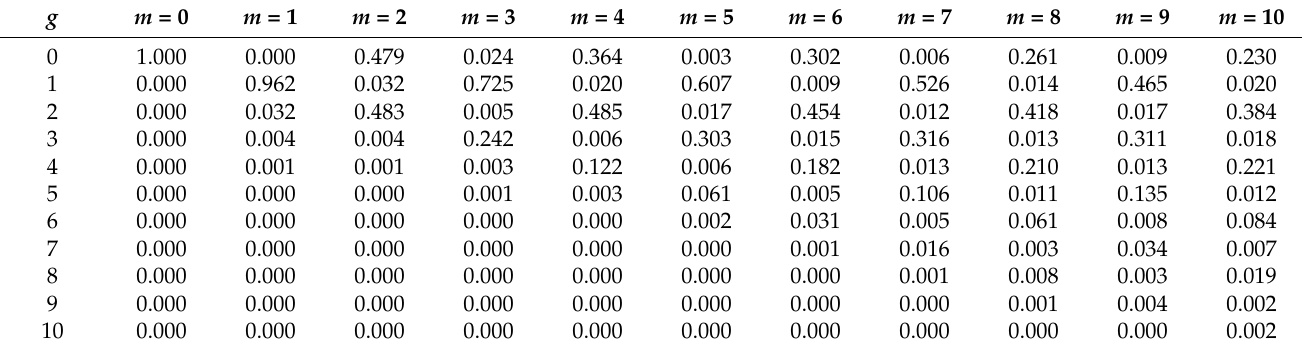
Table 1. Computed probabilities P ( g | m ) of obtaining genetic distance g from m